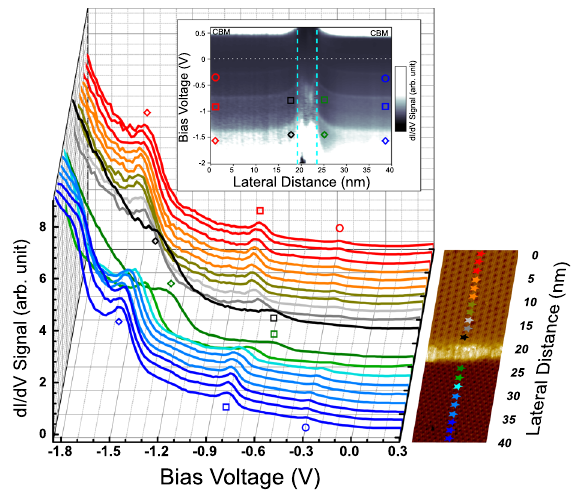
Fig. 2 Spatially resolved STS across the grain boundary. (Set point: = − 0.5 V, I = 0.5 nA) The upper and lower parts are the R(37/ V bias set 61) and R(19/31) regions, respectively. The spectra show the energy shift of the peaks when the measurement point approaches the boundary. The inset displays the STS line pro fi le. The aqua dashed line labels the boundary of contaminations and the white dashed line labels the Fermi level. The diamonds, squares, and circles represent the three peaks. We observe that the diamonds belonging to the R(19/31) region are shifted from − 1.46 V (blue) to − 1.28 V (green), and the squares are shifted from − 0.78 V move to − 0.62 V. For the circles, they shift from − 0.29 to − 0.22 V, but vanish very near the boundary (deep green curve). In the R(37/61) region, the diamonds are shifted from − 1.49 V (red) to − 1.34 V (black), and squares from − 0.78 to − 0.64 V. The circles shift from − 0.29 to − 0.22 V and also vanish near the boundary (black curve)